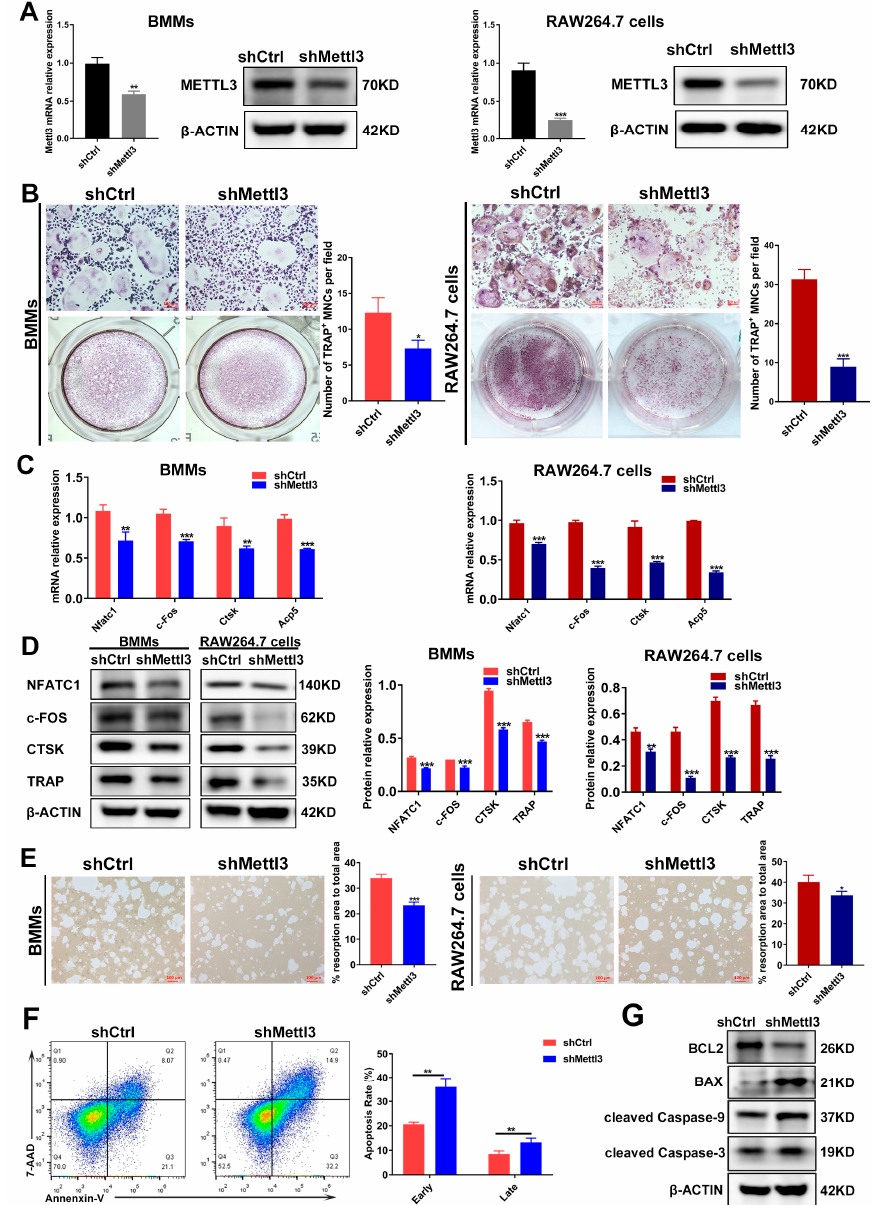
Figure 2. Effect of METTL3 knockdown on osteoclast differentiation, bone resorption capacity and osteoclast apoptosis under inflammatory conditions. ( A ) qRT-PCR and Western blotting were utilized to assess the efficiency of METTL3 knockdown. shCtrl, cells transfected with the negative control shRNA; shMettl3, cells transfected with the shRNA targeting Mettl3 . ( B – G ) BMMs and RAW264.7 cells with or without METTL3 knockdown were induced to differentiate into osteoclasts as described previously. ( B ) Images of TRAP staining. Scale bars, 100 µ m. ( C ) The mRNA expression of Nfatc1 , c-Fos , Ctsk and Acp5 was assessed by qRT-PCR. ( D ) The protein levels of NFATC1, c-FOS, CTSK and TRAP were detected using Western blotting. ( E ) Osteoclast bone-resorbing capacity was assessed using pit formation assay. Quantification of the resorption area is shown. Scale bars, 100 µ m. ( F ) Apoptosis of osteoclasts differentiated from RAW264.7 cells was detected using flow cytometry analysis. Early apoptotic cells were stained Annexin V-positive and 7AAD-negative, while late apoptotic cells were Annexin V-positive and 7AAD-positive. ( G ) Western blotting was performed to evaluate the protein levels of BCL2, BAX and cleaved caspase-9, -3. β -Actin was used as an internal control for qRT-PCR and Western blotting. The data are shown as the mean ± SD ( n = 3). * p < 0.05; ** p < 0.01; *** p <